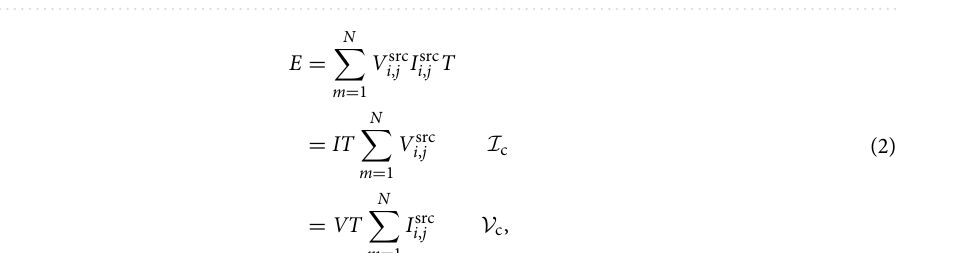
Figure 2. ERT electrical conductivity maps of sample S obtained with measurement protocols I c (constant current) and V c (constant voltage) at increasing excitation energy E . Maps A and C correspond to low sample excitation energy E < 55 µ J , while maps B and D correspond to higher sample excitation energy E > 5.5 µ J . Map difference B − A and D − C show the pixel-by-pixel absolute difference between the corresponding conductivity